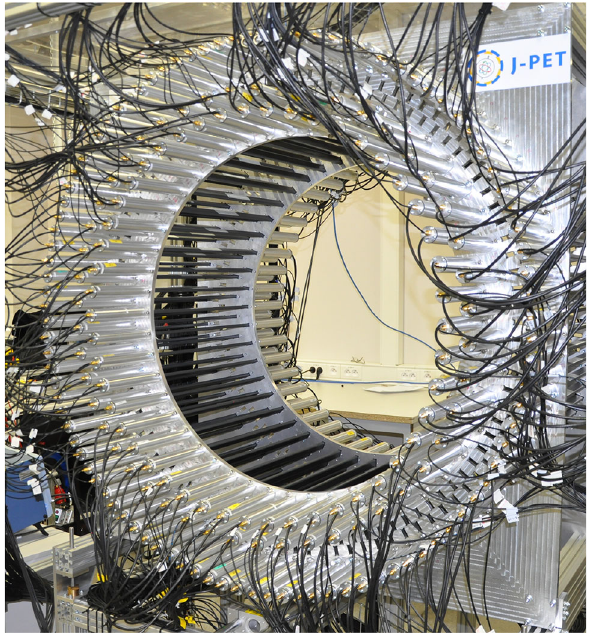
Fig. 1 Photo of the J-PET detector. The inner part of the detector is of a cylindrical shape with the length of 50 cm and diameter of 85 cm. The detector is made of three layers of plastic scintillator strips (black) and readout by vacuum tube photomultipliers (gray)